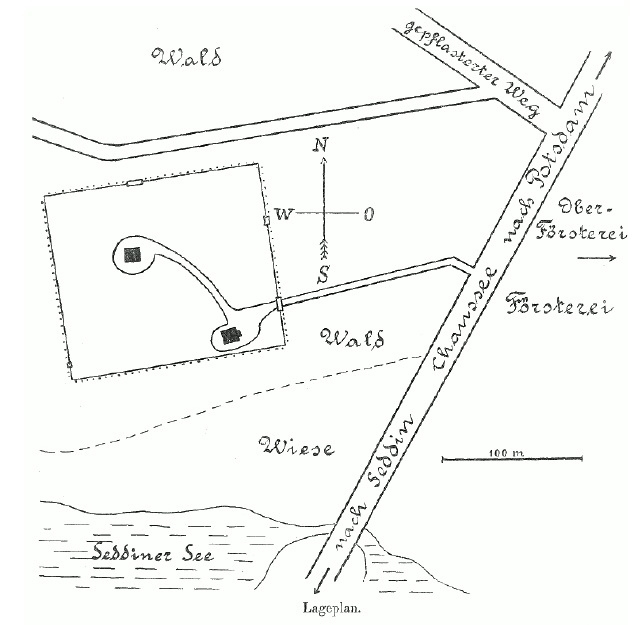
Figure 1. Sketch of the Seddin Observatory compound. Source: Schmidt (1910).